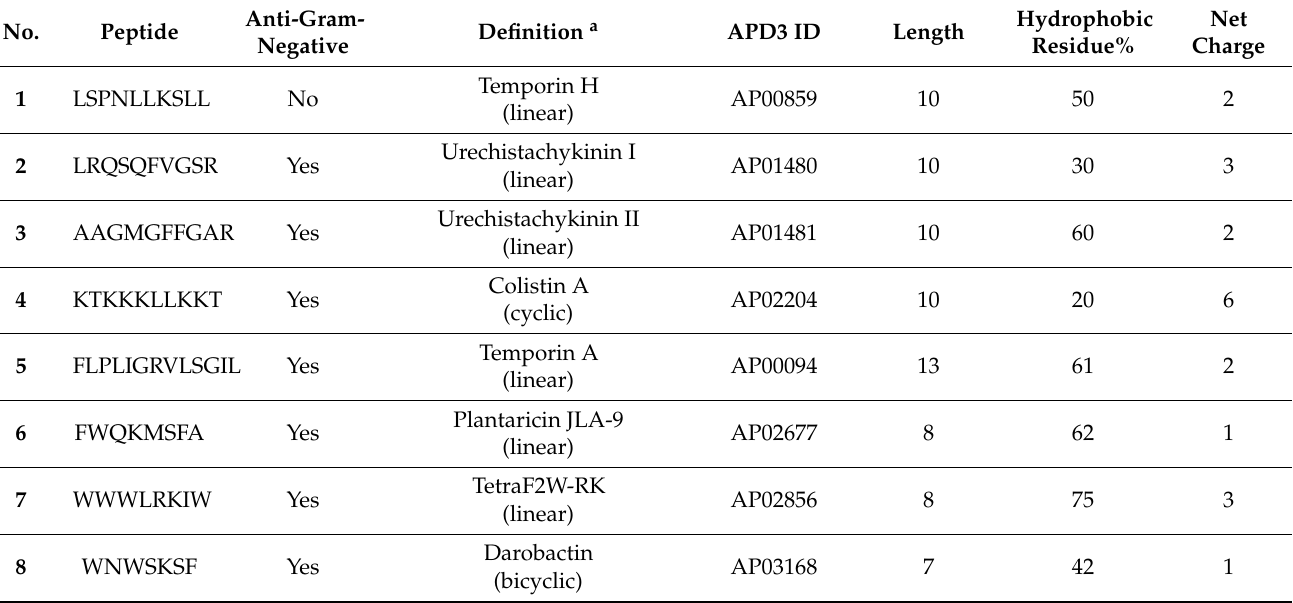
Table 2. Information on the screened AMPs. All peptides are effective against Gram-negative